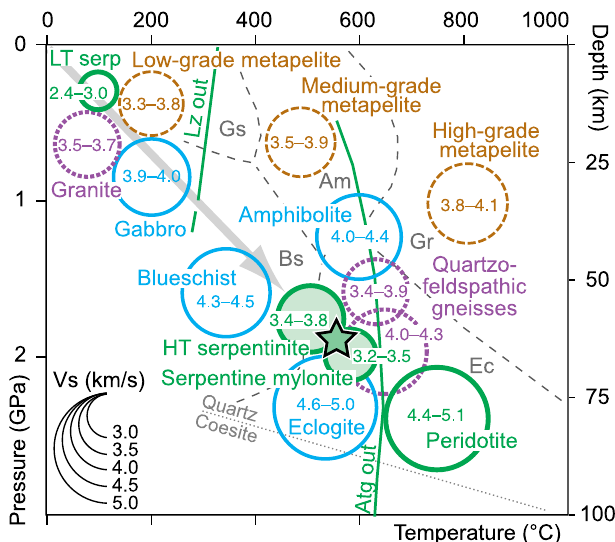
Fig. 3 Measured Vs (km s − 1 ) for different rocks (green = ultrama fi c; blue = ma fi c; purple = granitic; brown = pelitic) at ambient conditions. The size of the circles is proportional to Vs, while circle location depends on the pressure – temperature range at equilibrium for each rock type 23,31 – 39,56 . The Vs range of 4.0 – 4.3 km s − 1 in quartzofeldspathic gneisses is based on calculations for modeled rocks at 700 °C and 2 GPa 36 . The lower bound for HT serpentinite (3.4 kms − 1 ) is calculated from single-crystal elastic data and referred to Reuss approximation and 2 GPa 23 . Lizardite (Lz) and antigorite (Atg) stability fi elds 57,58 . The dashed gray lines indicate the metamorphic facies boundaries (Am amphibolite, Bs blueschist, Ec eclogite, Gr granulite, Gs greenschist). Note the progressive increase in Vs with depth and metamorphic grade in pelitic, granitic, and ma fi c rocks, and the sharp change in Vs across the Atg-out curve in ultrama fi c rocks. The green star marks the rock types consistent with Vs and depth of the analyzed low- velocity